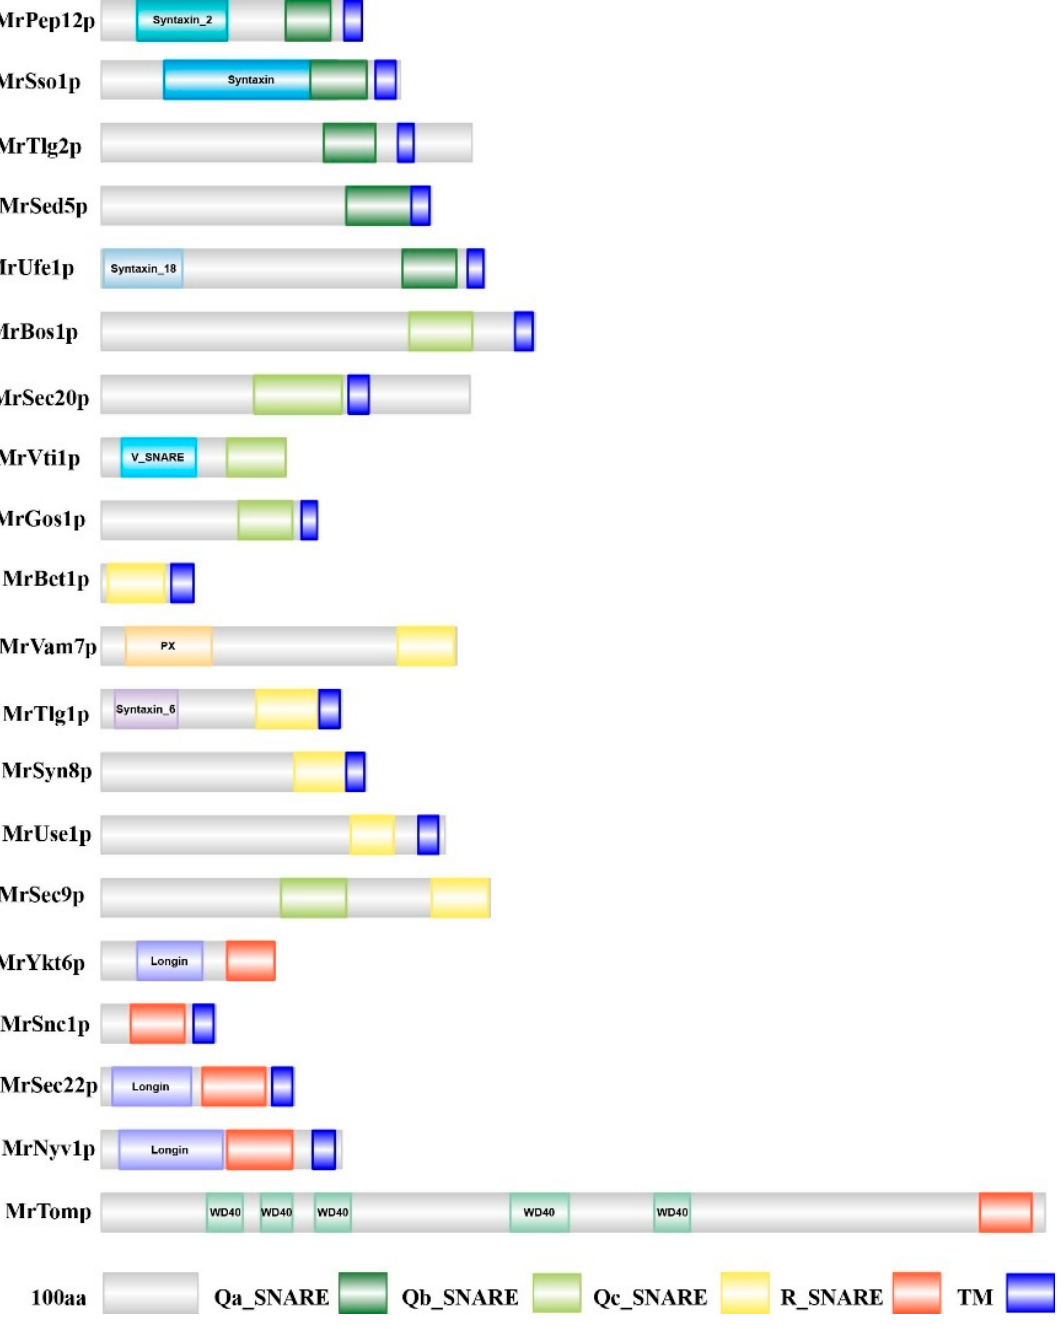
Figure 2. Identification of conserved domains of MrSNAREs. Dark green cylinders represent the Qa_motif, light green cylinders represent the Qb_motif, yellow cylinders represent the Qc_motif, red cylinders represent the R_motif, and blue cylinders represent the TM domain.